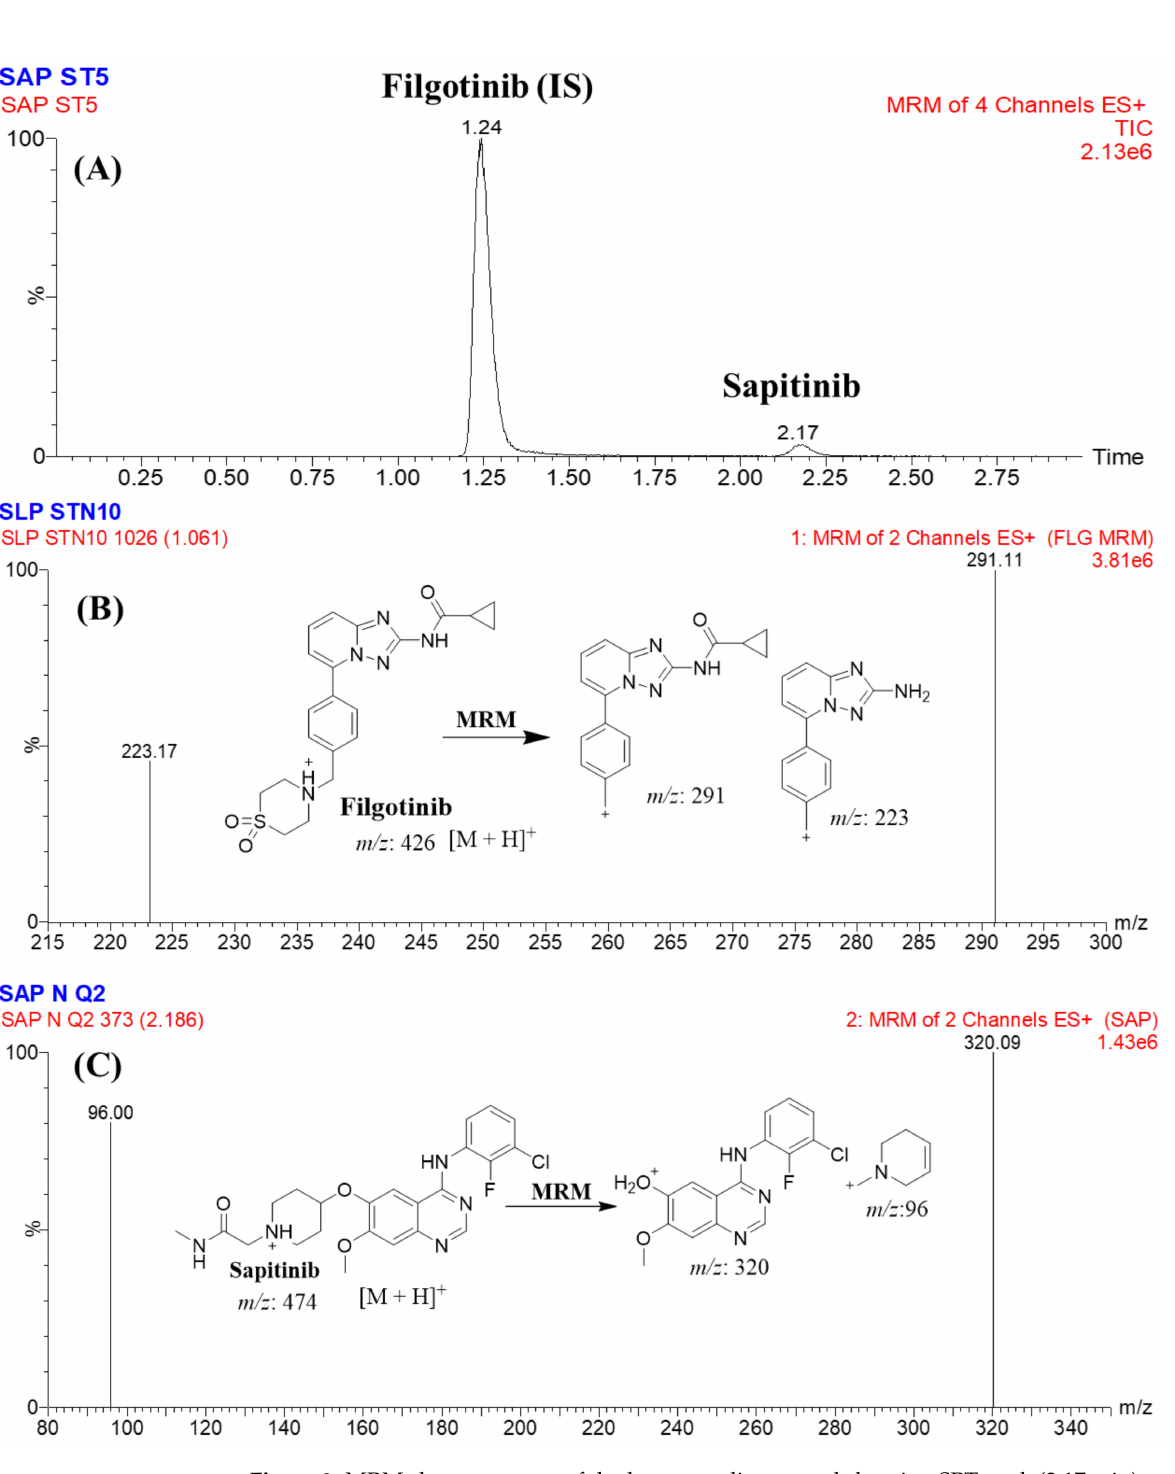
Figure 3. MRM chromatogram of the lower-quality control showing SPT peak (2.17 min) and FGT peak (1.24 min) ( A ). MRM mass spectrum of FGT ( B ). MRM mass spectrum of SPT ( C